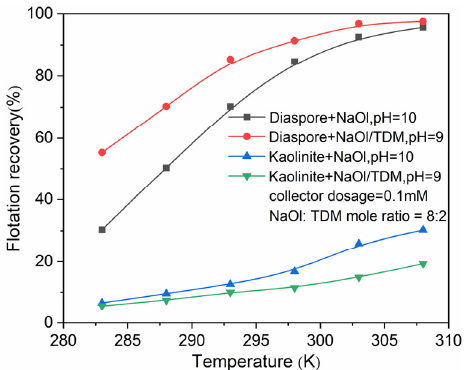
Figure 4. Effect of the flotation temperature on diaspore and kaolinite flotation with NaOl (pH = 10, dosage = 0.1 mM) or NaOl/TDM (pH = 9, dosage = 0.1 mM, NaOl:TDM mole ratio = 8:2).